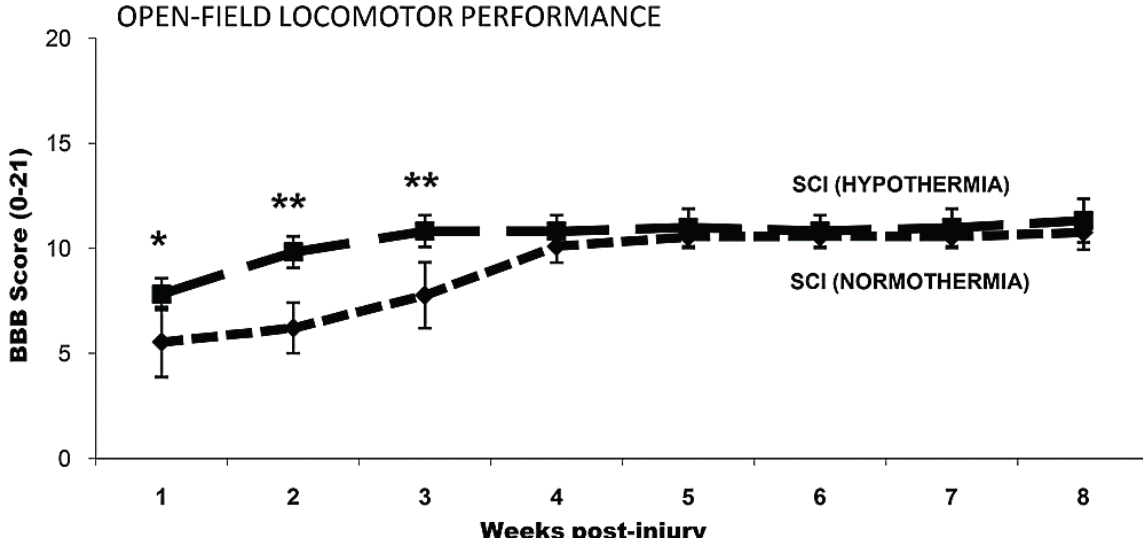
Figure 1. Open field locomotor ability was significantly improved acutely but not persistently following hypothermia. Locomotor performance was assessed from one week post-injury through eight weeks according to the Basso-Beattie-Bresnahan (BBB) scale. Although a significant increase in BBB scores was observed transiently one to three weeks after injury with hypothermia over normothermic controls, both groups achieved similar behavioral endpoints by eight weeks. Data are expressed as average ± standard error of the mean. Group numbers: n = 9 normothermic injured group and n = 9 hypothermic injured group. ** p < 0.01, * p < 0.05 compared with normothermic controls. Reprinted with permission from [42], copyright Wiley-Liss, Inc.,